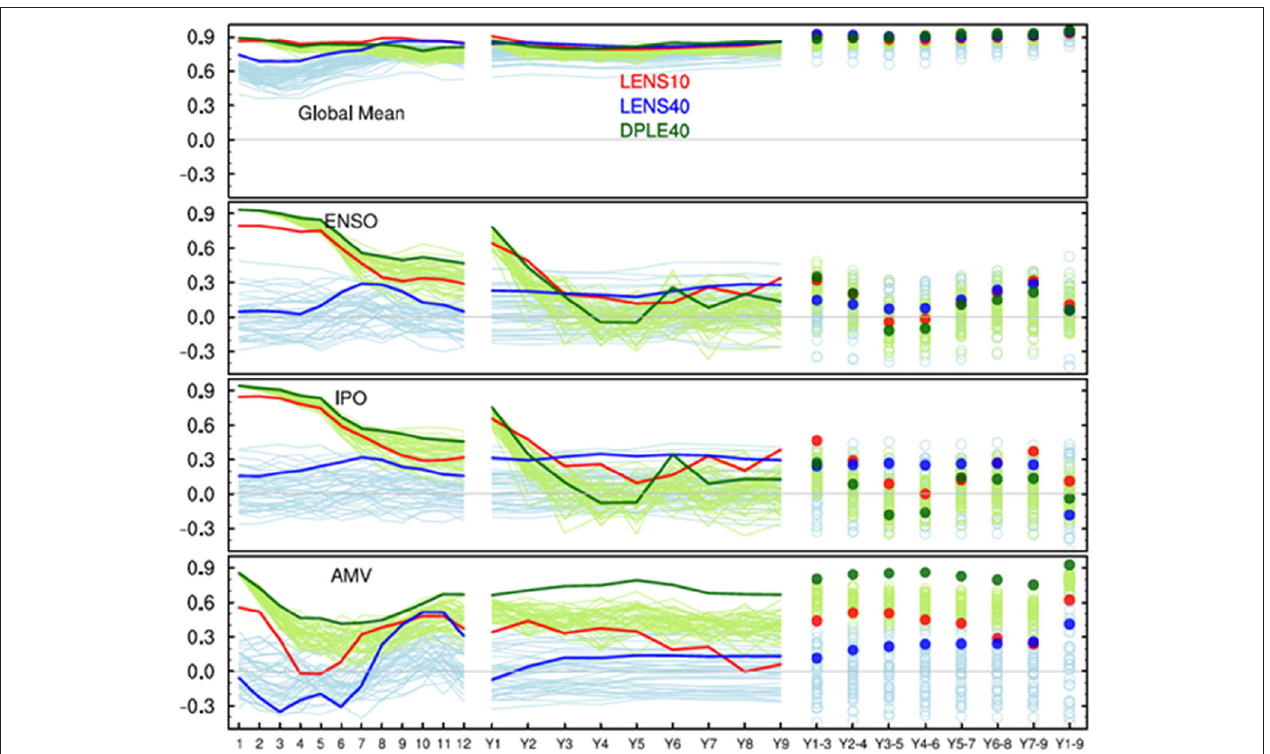
FIGURE 5 | Correlation skill for different forecast times: left lines represent skill for first 12 forecast months; center lines represent skill for first nine forecast years; dots represent skill for multi-annual mean forecasts. IPO is calculated as a tripole index ( Henley et al., 2015) from SST anomalies, ENSO is based on area-weighted mean of SST anomalies at Nino3.4 region (i.e., 5 ◦ S − 5 ◦ N, 170 ◦ W − 120 ◦ W), and AMV is calculated as a weighted area average SST anomalies for 0–60 ◦ N of the North Atlantic ocean with global mean (60 ◦ S − 60 ◦ N) SST